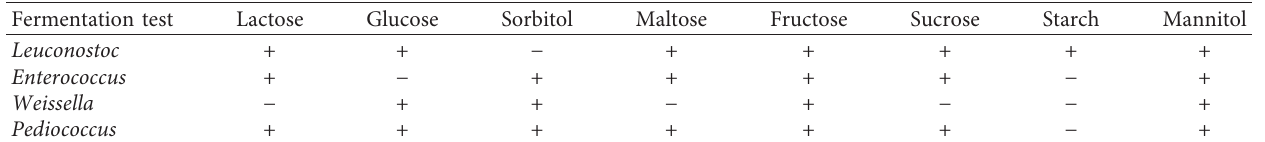
Table 4: Summary of carbohydrate utilization